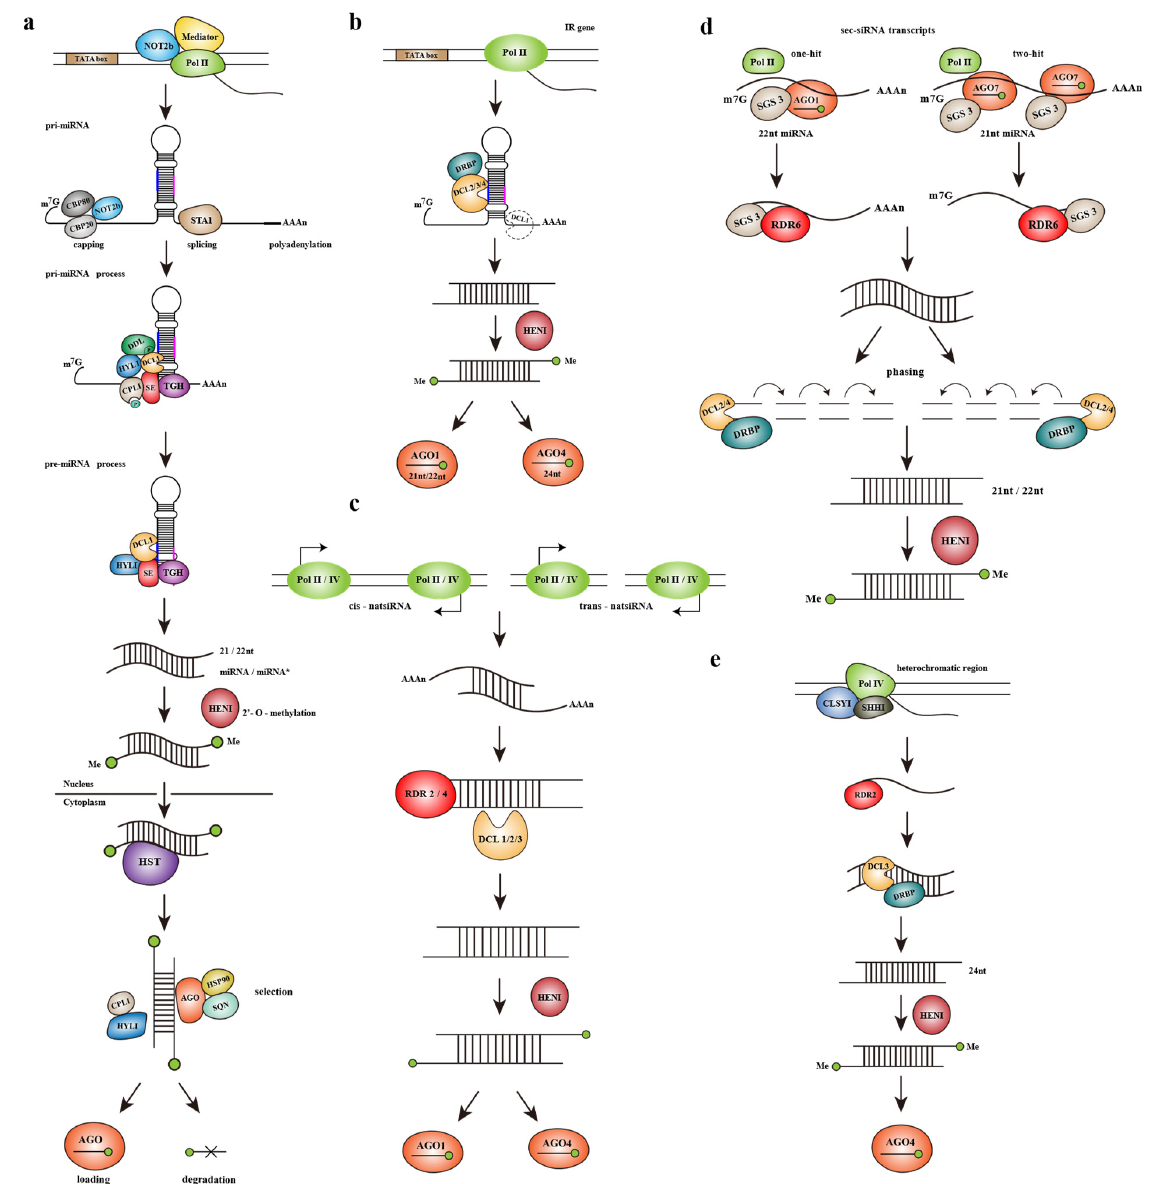
Figure 2. Biogenesis of sRNAs involved in post transcriptional gene silencing and transcriptional gene silencing. ( a ) The micro-RNA (miRNA) pathway. ( b ) The inverted repeat (IR)–derived hairpin- siRNA (hp-siRNAs) pathway. ( c ) The natural-antisense small interfering RNA (natsiRNA) pathway. ( d ) The trans-acting siRNA (tasiRNA) pathway. ( e ) The heterochromatic siRNA (hetsiRNA) biogen- esis pathway. Additional abbreviations: m7G, 7-methylguanylate cap; AAAn, polyadenine tail; CBP, CAP-BINDING PROTEIN; STA1, STABILIZED 1; DDL, DAWDLE; DCL, DICER-LIKE; HYL1, HYPONASTIC LEAVES 1; CRL1, C-TERMINAL DOMAIN PHOSPHATASE-LIKE 1; SE, SERRATE; TGH, TOUGH; HEN1, HUA ENHANCER 1; HST, HASTY; AGO, ARGONAUTE; HSP90, HEAT- SHOCK PROTEIN 90; SQN, SQUINT; DRBP, double-stranded RNA-binding protein; SGS3, SUP- PRESSOR OF GENE SILENCING 3; RDR, RNA-dependent RNA polymerase; CLSY1, CLASSY 1;